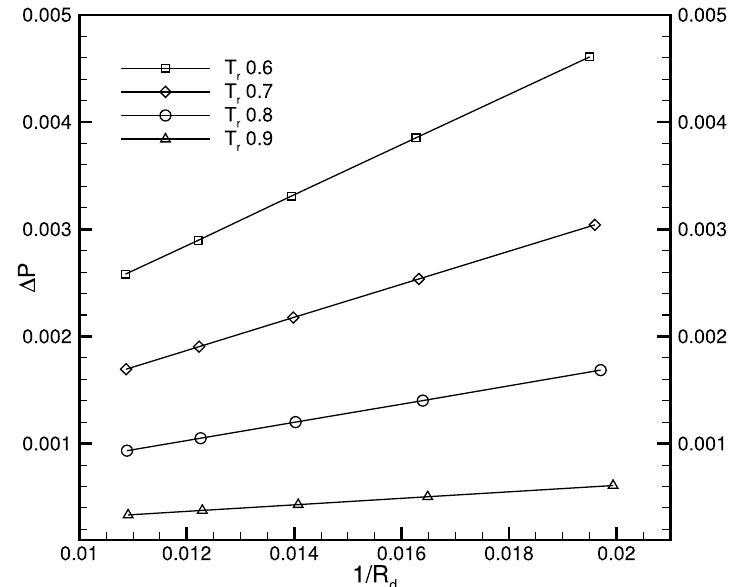
Fig. 9 Validation of Laplace’s law, τ =